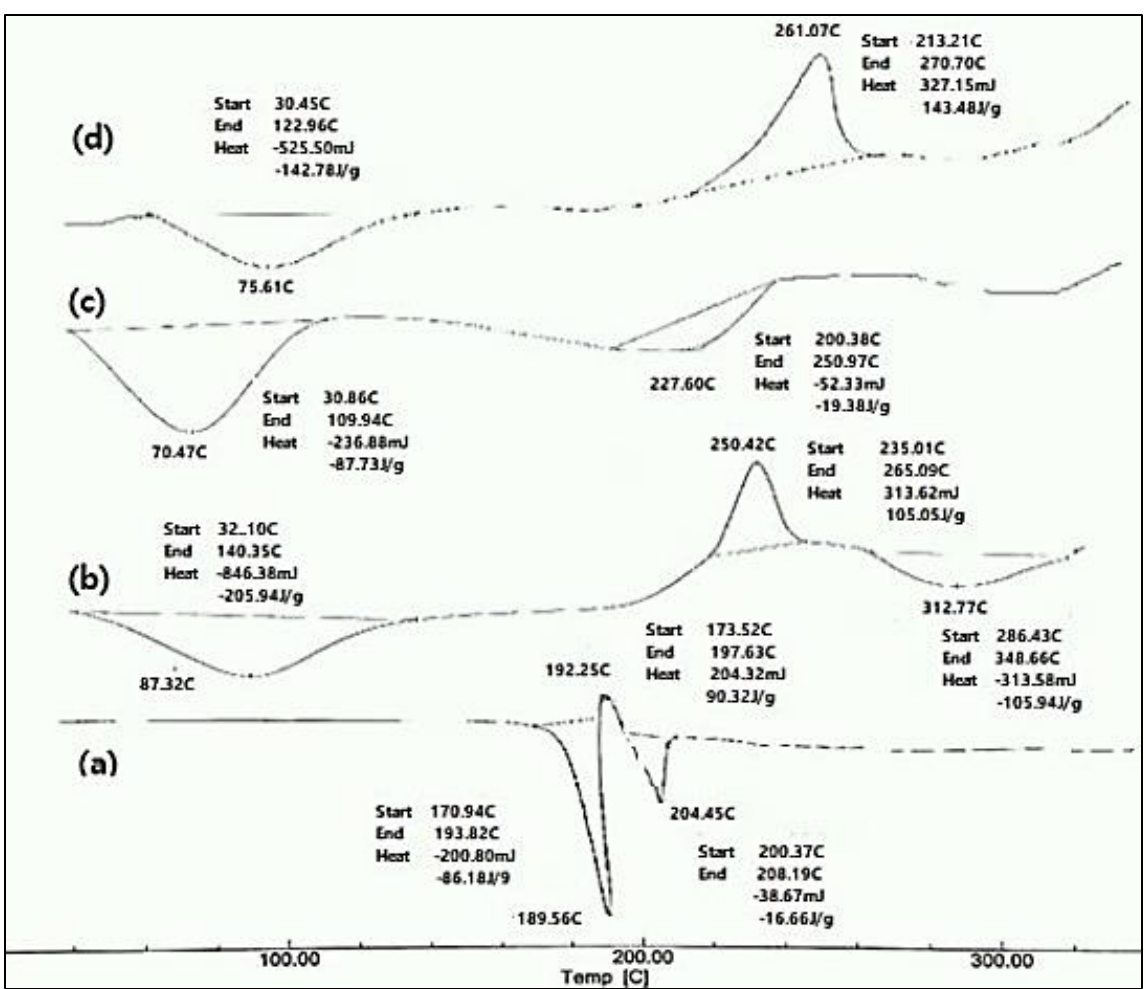
Figure 1. DSC thermograms of ( a ) pure drug (BH), ( b ) Na alginate, ( c ) HPMC K15M, and ( d ) physical mixture of the drug with Na alginate and HPMC K15M.